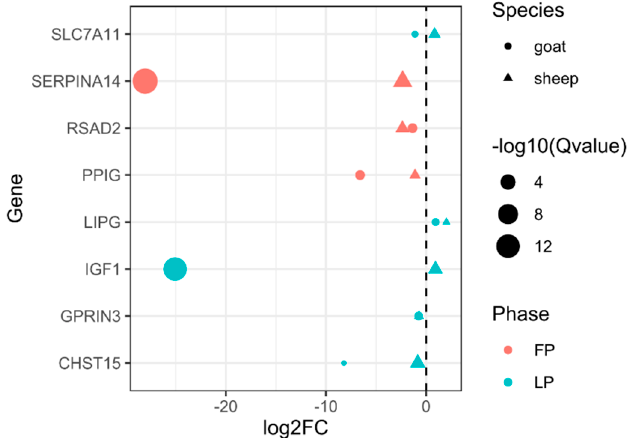
Figure 4. Differentially expressed genes of ovaries shared by sheep and goats. FP and LP denote follicular and luteal phases, respectively.